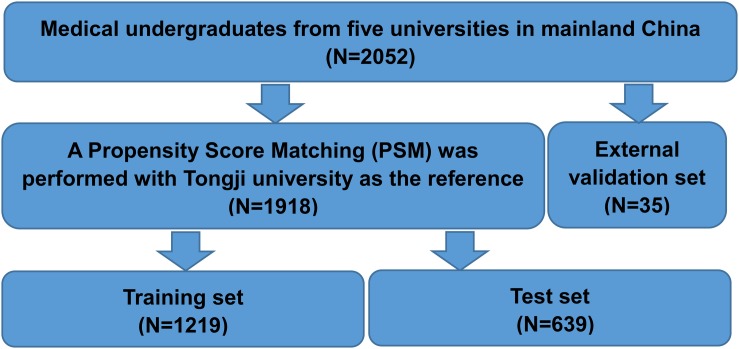
Flow chart for data selection. PSM, propensity score matching.